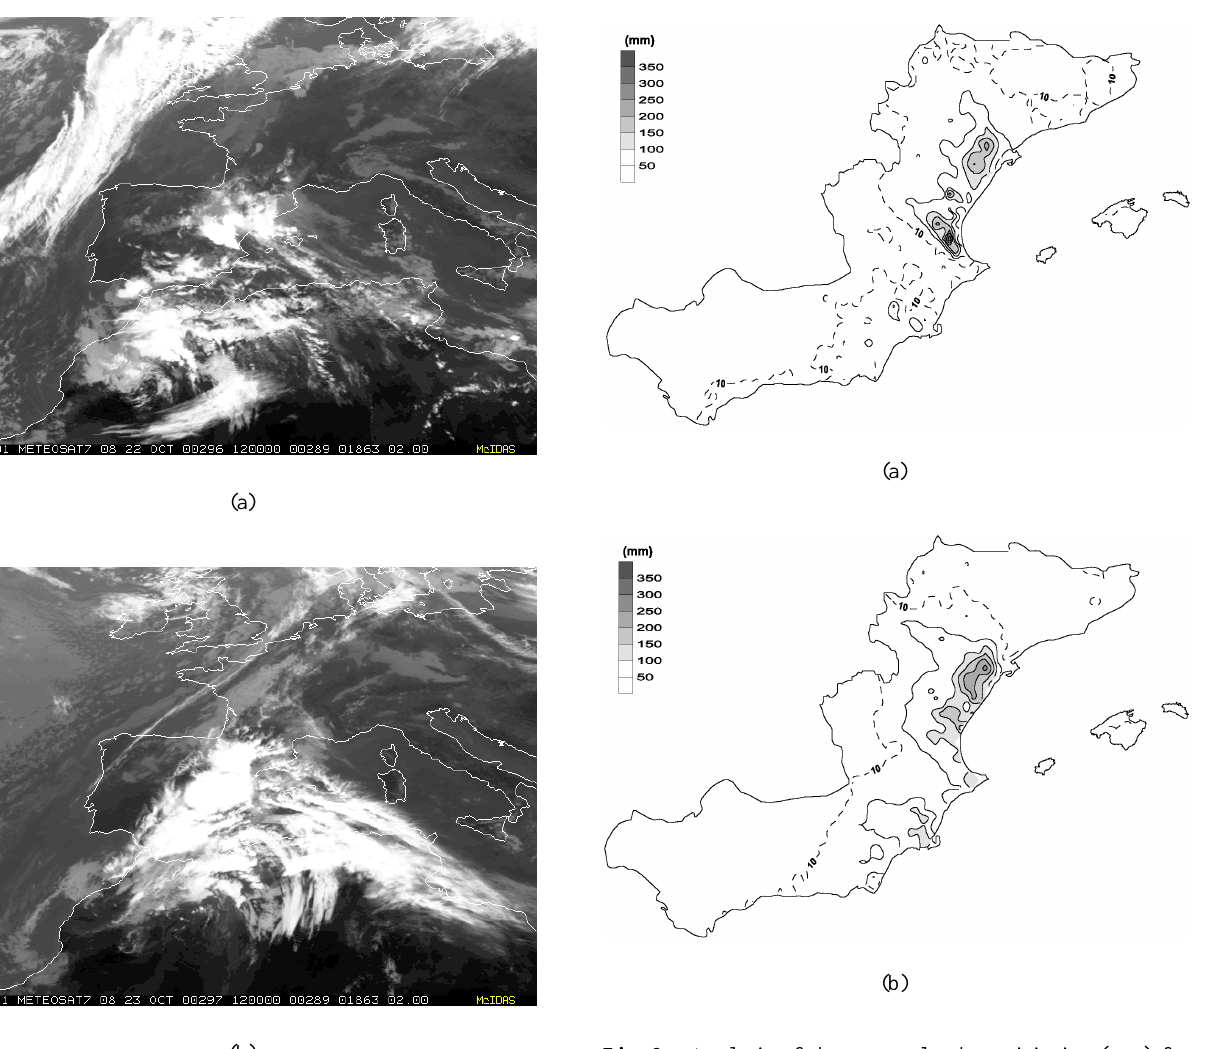
Fig. 6. Analysis of the accumulated precipitation (mm) from 07:00UTC to 07:00UTC the next day on: (a) 22 and (b) 23 Oc- tober 2000. The stations and the covered area is the same as in Fig. 2. higher than 150 mm was detected south of Catalonia. Signif- icant precipitation occurred on 22 October over a widespread area covering the Catalonia, Valencia and Murcia regions (Fig. 6a). The largest amounts were registered along coastal areas of south Catalonia and Valencia, with nuclei of 200